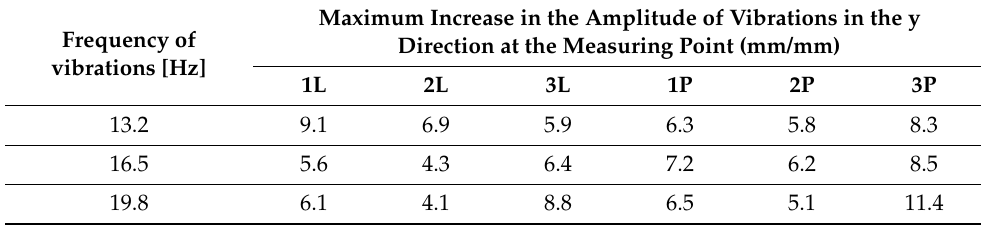
Table 8. Maximum multiples of vibration amplitude values in the y